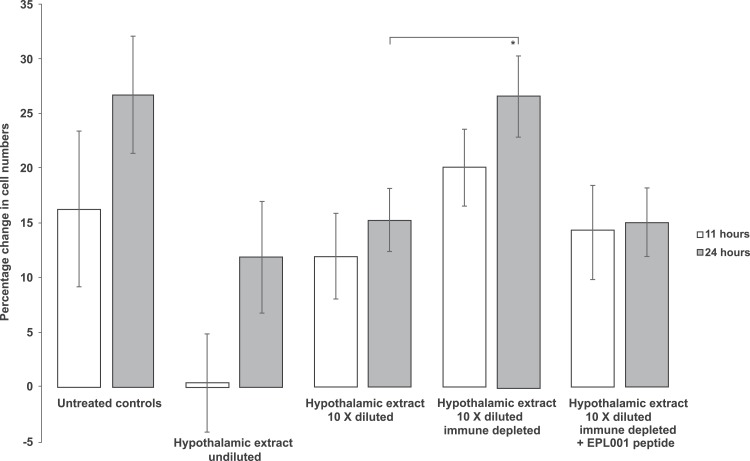
Rat bone marrow cells in culture exposed to rat hypothalamic extract in different forms.The extract was provided neat, diluted and immunodepleted (using an anti-EPL001 antibody, without and with the presence of EPL001 peptide). Data are mean ± SEM; four replicates per group. Students t-test: *P = 0.050 (other groups narrowly ns: e.g. untreated controls 24 h vs hypothalamic extract undiluted 24 h, P = 0.09; Hypothalamic extract 10× diluted + PP vs the same + EPL001, P = 0.06).